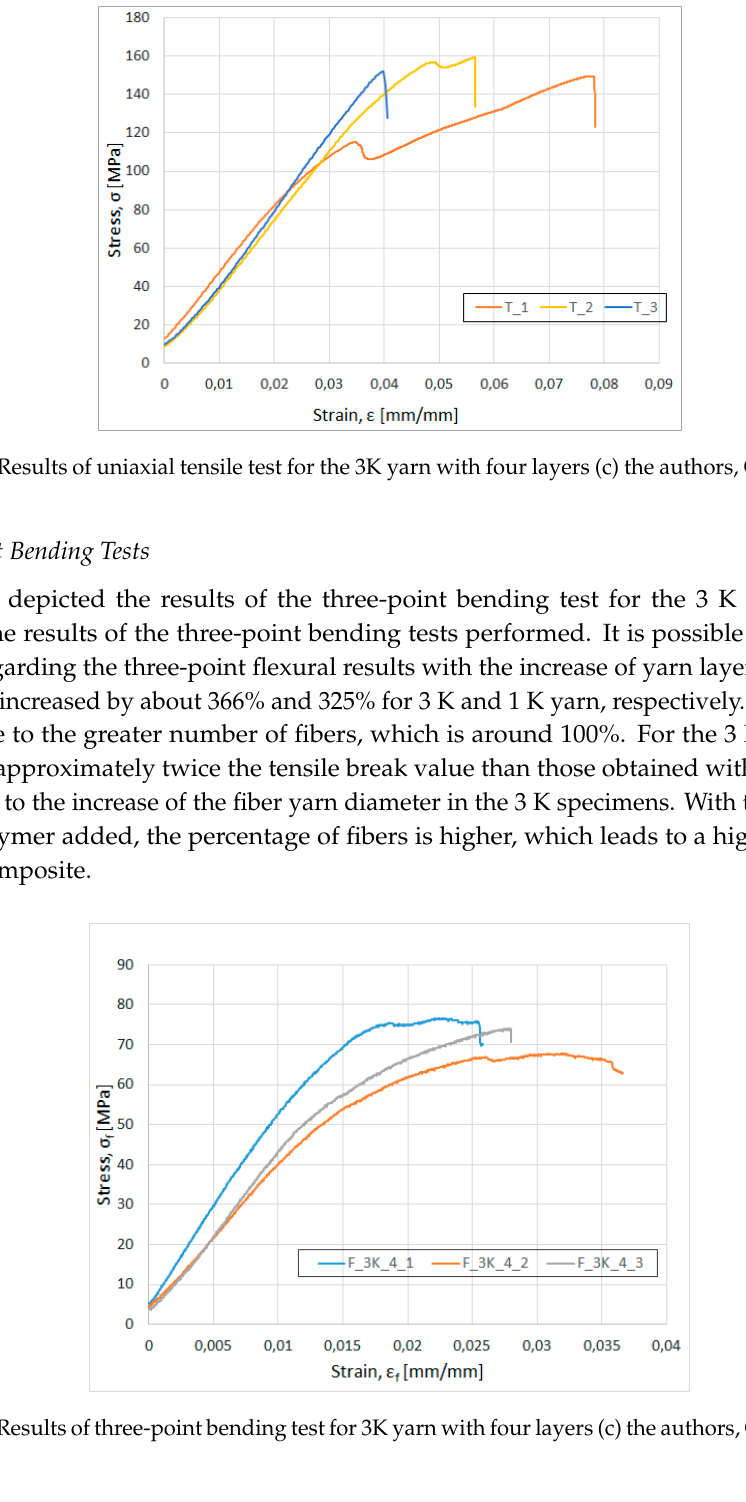
Figure 10. Results of uniaxial tensile test for the 3K yarn with four layers (c) the authors, CC BY-NC-ND 4.0 [17].